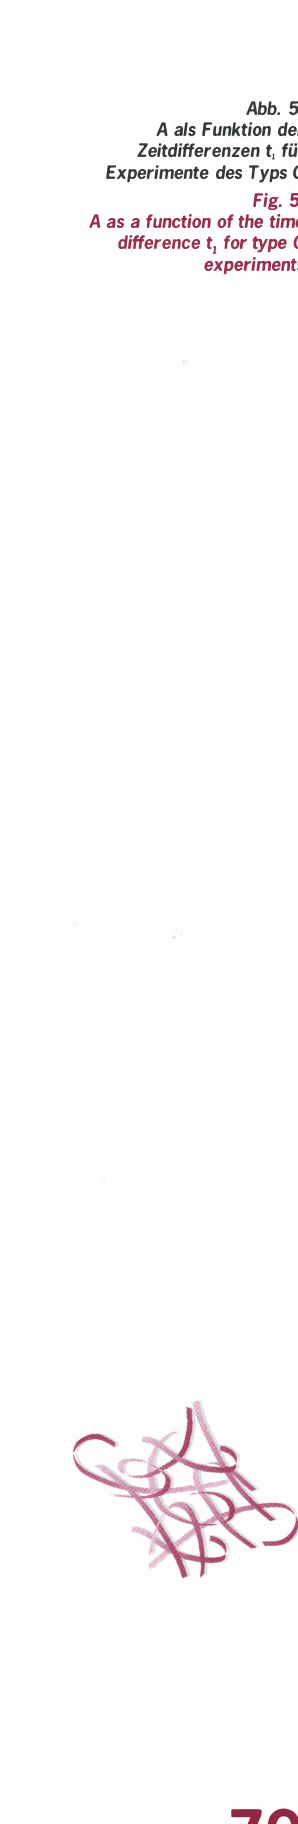
Fig. 4: f2 as a function of strain for